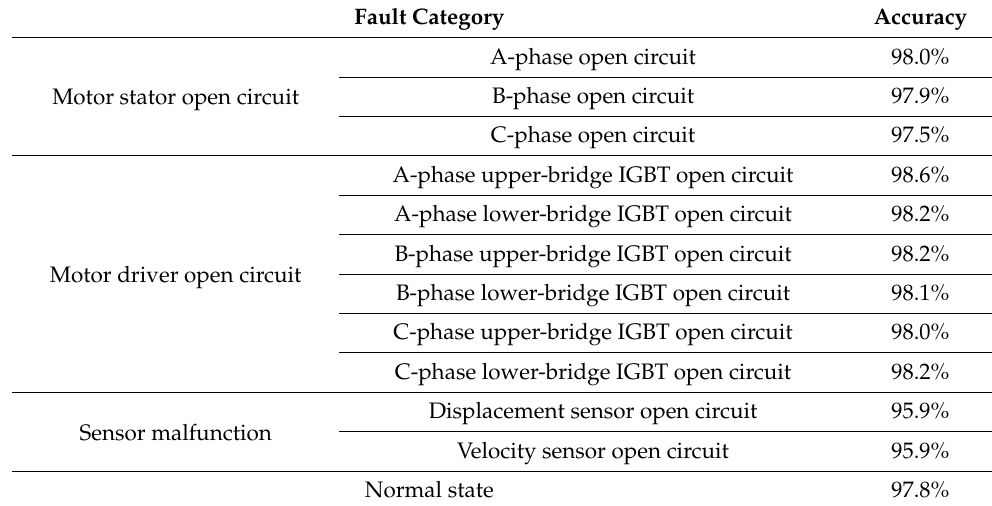
Table 2. Fault diagnosis